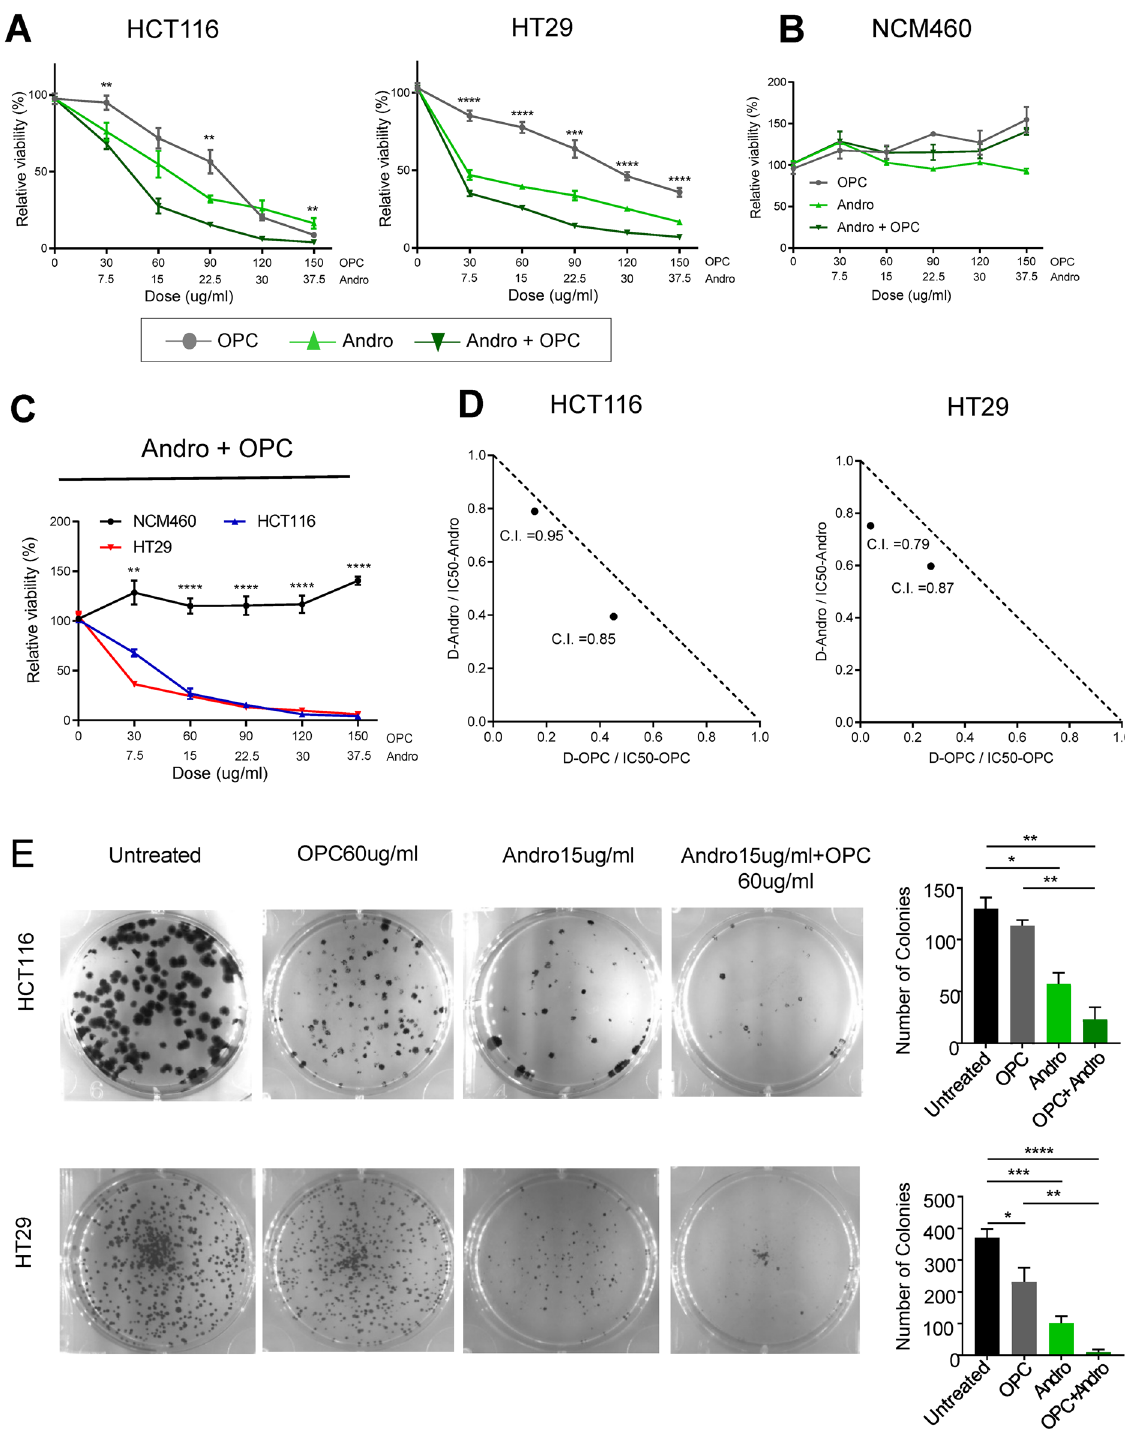
Figure 1. Andrographis and oligomeric proanthocyanidins (OPCs) enhance tumor suppressive effects in CRC cells. ( A ) Results of WST assay to compare cell viability following treatment with andrographis, OPCs and their combination for 72 h in HCT116 and HT29 cell lines. ( B ) Results of WST assay to compare cell viability following treatment with Andrographis, OPCs and their combination for 72 h in NCM460 normal colon epithelial cell. ( C ) Comparison of cell viability by WST assay following combination treatment between HCT116, HT29, and NCM460 cells. ( D ) Isobologram including Chou-Talalay combination index (CI) based on WST assay results to determine synergistic effects of andrographis and OPCs in HCT116 and HT29 cell lines. ( E ) Results of colony formation assay to assess clonogenicity of CRC cells following treatment with andrographis, OPCs, and the combination of both compounds for 7 days. Statistical significance is as follows; *P < 0.05, **P < 0.01, ***P < 0.001, and ****P < 0.0001 by one-way ANOVA